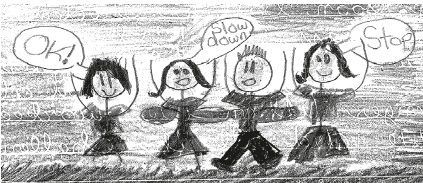
Figure 6: Photo journal drawing representing stage 3: developing